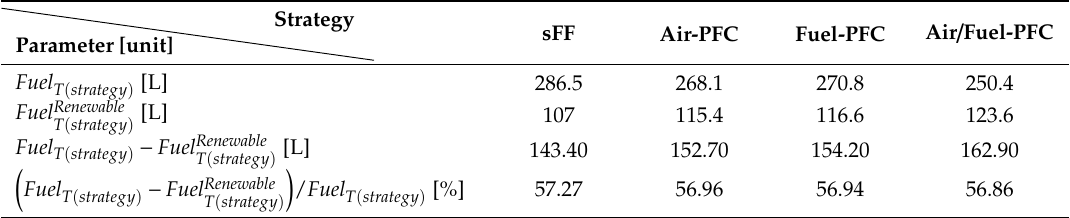
Table 5. Comparison of the fuel consumption using the strategies sFF, air-PFC, fuel-PFC, and air / fuel-PFC for the FC system and FC / renewable